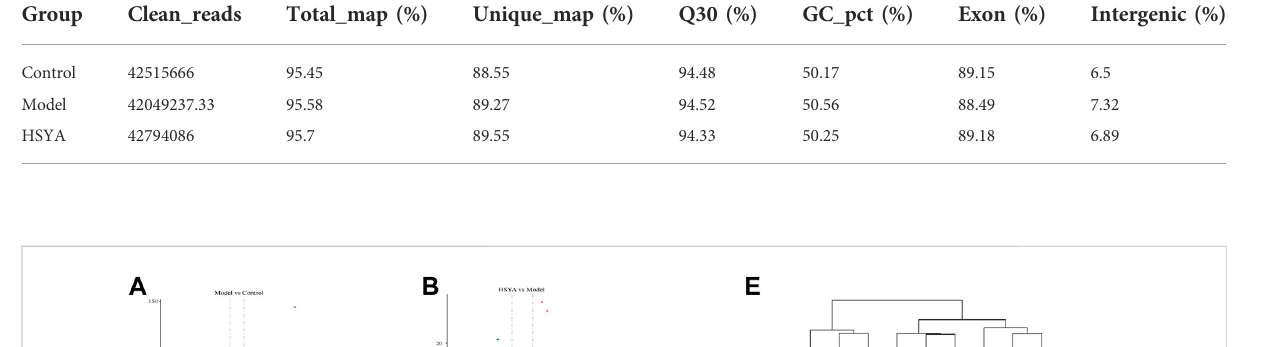
TABLE 2 RNA-seq data analysis. Group